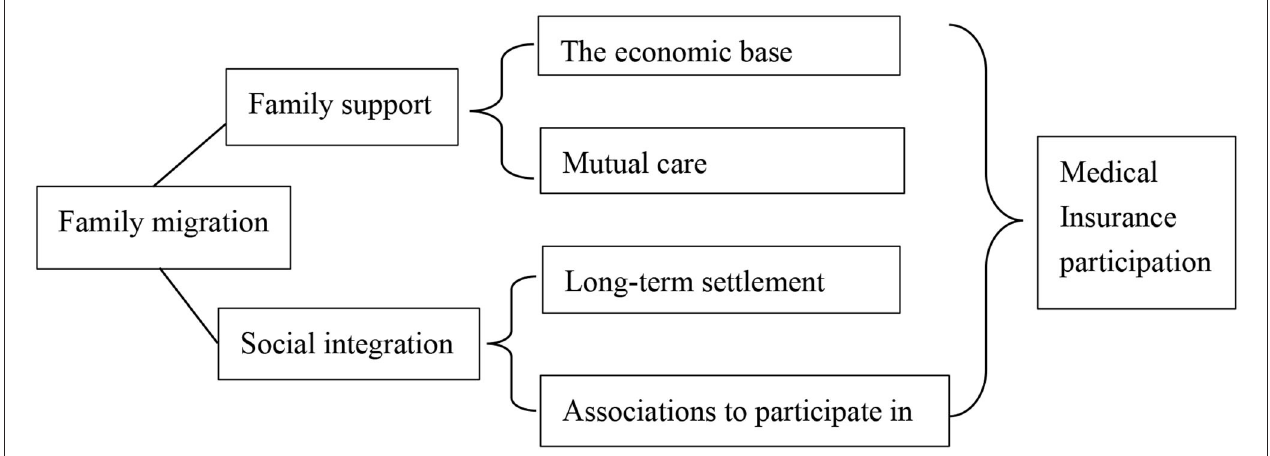
FIGURE 1 | Explanatory mechanisms of family migration’s promotion of health insurance participation at the